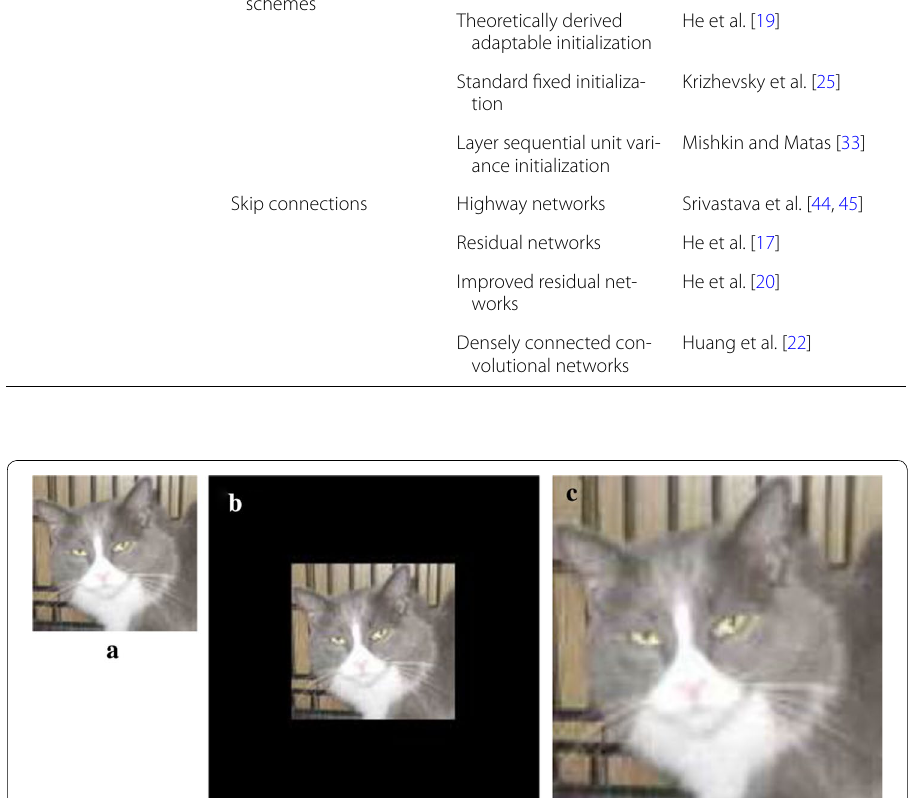
Fig. 2 A small image ( a ) resized to 200